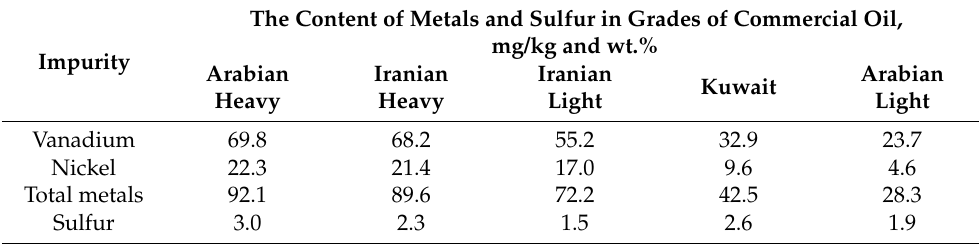
Table 8. The content of metals and sulfur in various grades of commercial oils of the Middle East [71].